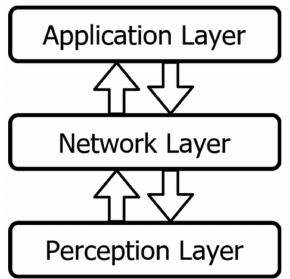
Figure 1. The common three-layer IoT